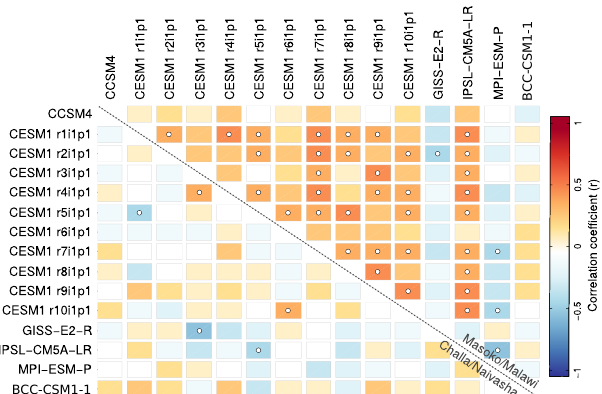
Figure 8. Pearson correlation coefficients between annual mean P - E over the last millennium (850–2005) as simulated by the differ- ent GCMs. The results were filtered using a loess method with a window of 100 years. The lower left half of the figure shows the re- sults for the Challa–Naivasha region, the upper right half the results for Masoko–Malawi. Squares with a central white circle represent combinations for which the null hypothesis of no correlation can be rejected at the 5%